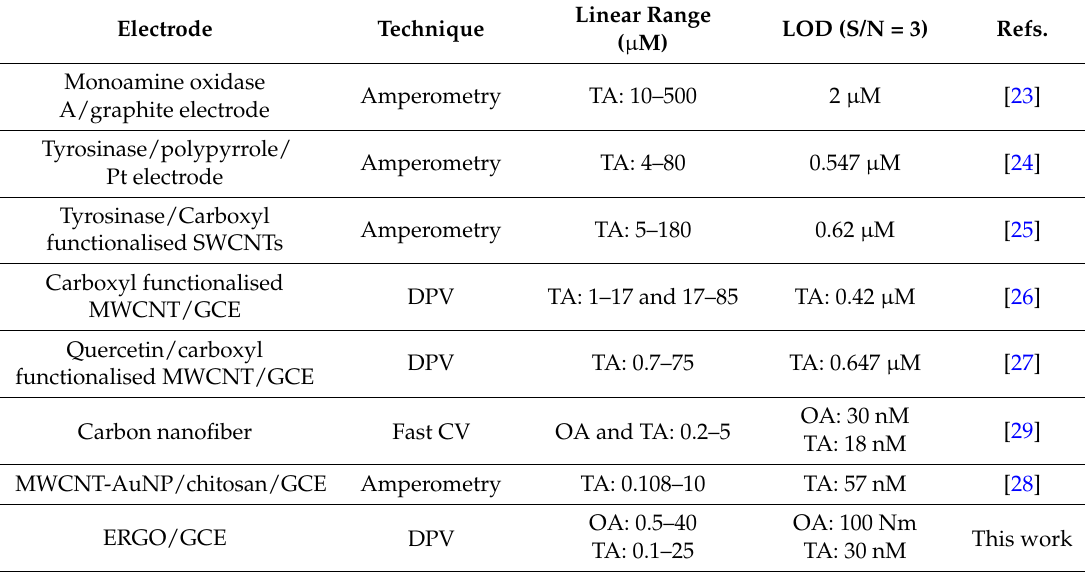
Figure 7. ( a , c ): DPV of ERGO/GCE in 0.1 M phosphate buffer solution (pH 7.0) containing different concentrations of OA ( a ) and TA ( c ). The DPV parameters of OA and TA were the same as Figure 3c,d, respectively; ( b , d ): The corresponding relationships of DPV anodic peak currents vs. the different concentrations of OA ( b ) and TA ( d ). Table 1. Comparison of the proposed ERGO/GCE with other reported electrodes for the determination of OA and